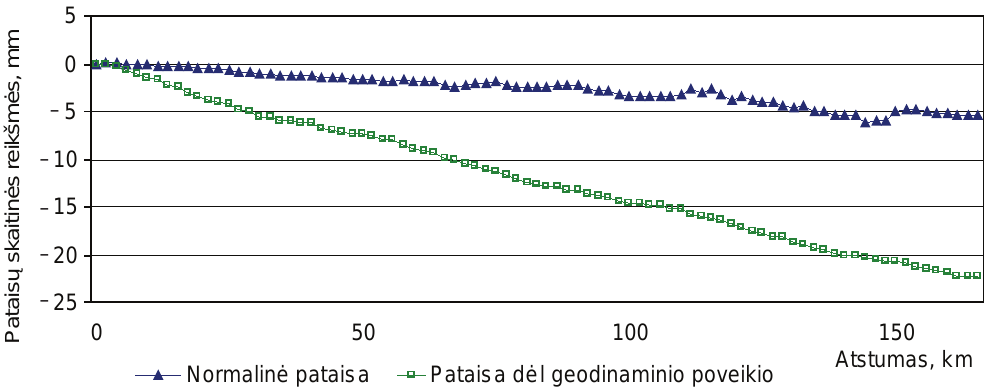
Fig. 4. Corrections to the measured differences in the altitudes: normal and caused by an impact of the vertical movements of the Earth’s crust (reducing into 2000) in the levelling line of Turmantas – Vilnius